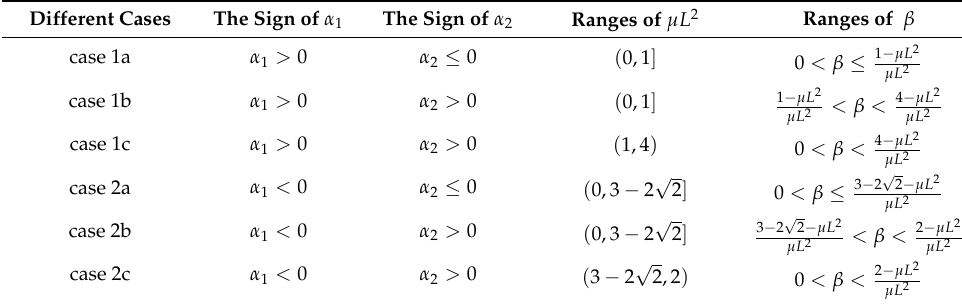
Table 1. The working ranges of inerter in different situations.